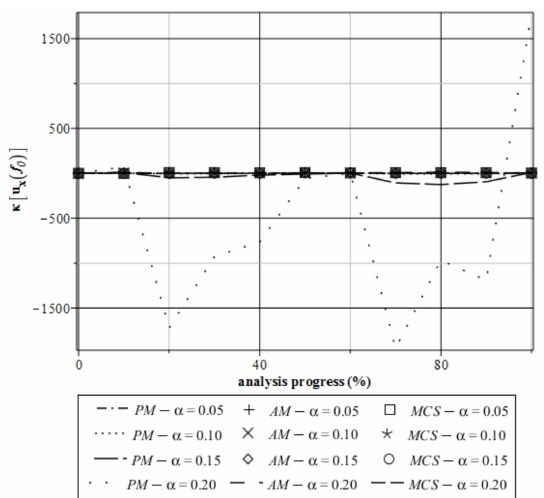
Figure 9. Skewness of the extreme horizontal displacements S[u x (f 0 )] for the specimen.